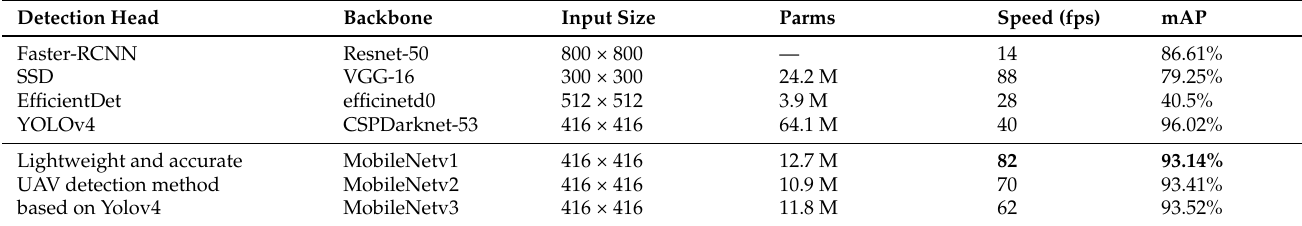
Table 5. Comparison of experimental results of different models.